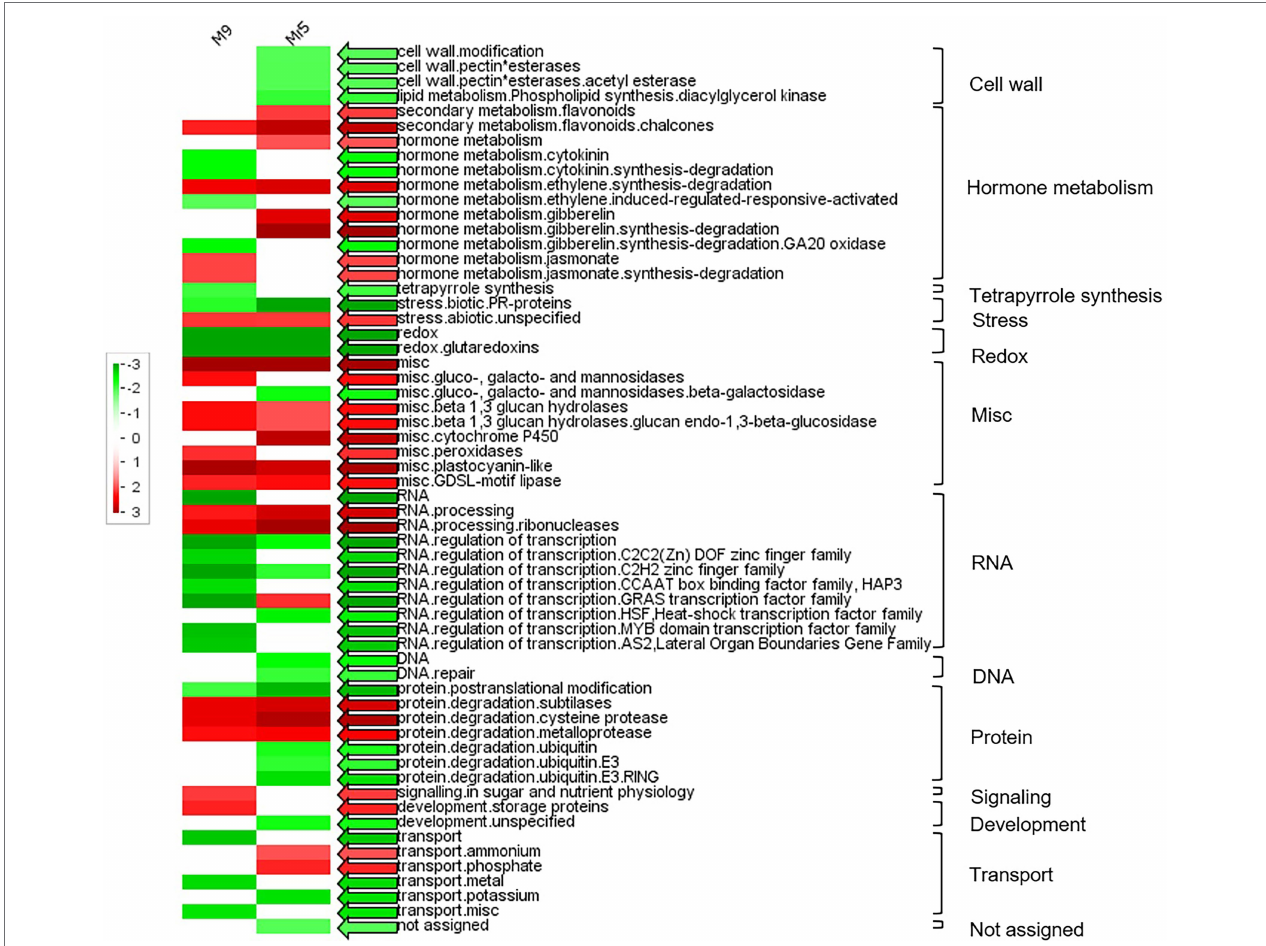
FIGURE 2 | PageMan display of significantly represented functional categories that were differentially regulated in roots of the susceptible rootstock ‘M9’ and the ARD tolerant wild apple species M. × robusta 5 (Mr5) plants after cultivation in ARD soil and compared to γ ARD soil. Colored boxes indicate statistically significant groups ( p < 0.05) after Wilcoxon test. The results are displayed as red-colored BINs (significantly over represented), green-colored BINs (significantly under represented) and white-colored BINs (not significant). The colored arrows indicate the highest significance found for the respective functional category. The MapMan annotations of the gene classes were displayed alongside each row and the main functional categories are displayed in the right. Non-significant categories are not